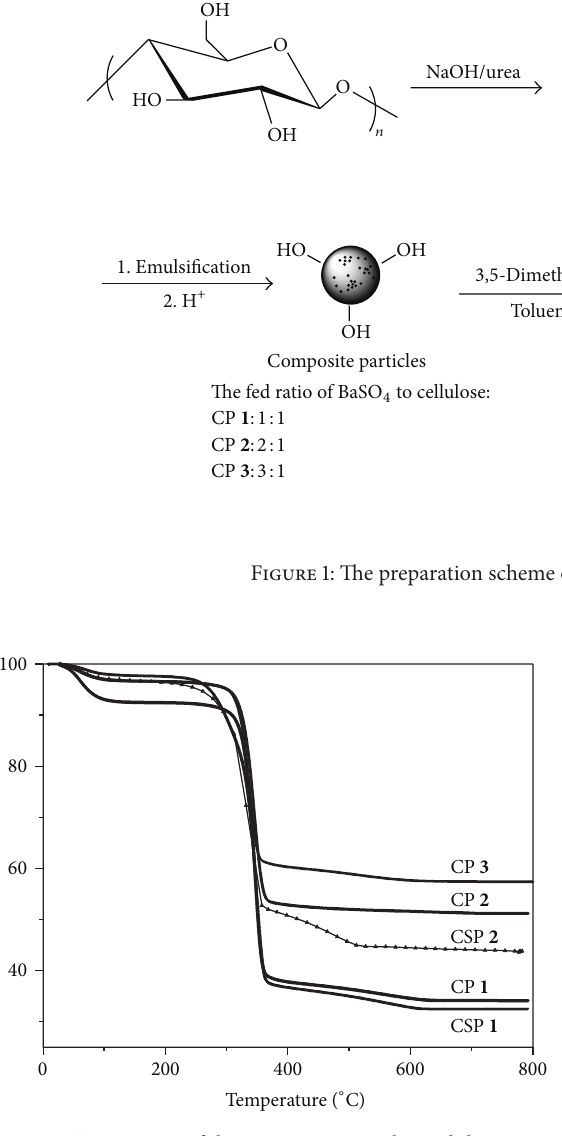
remaining amount after thermolysis than CSP 1 due to the higher BaSO 4 loading of the